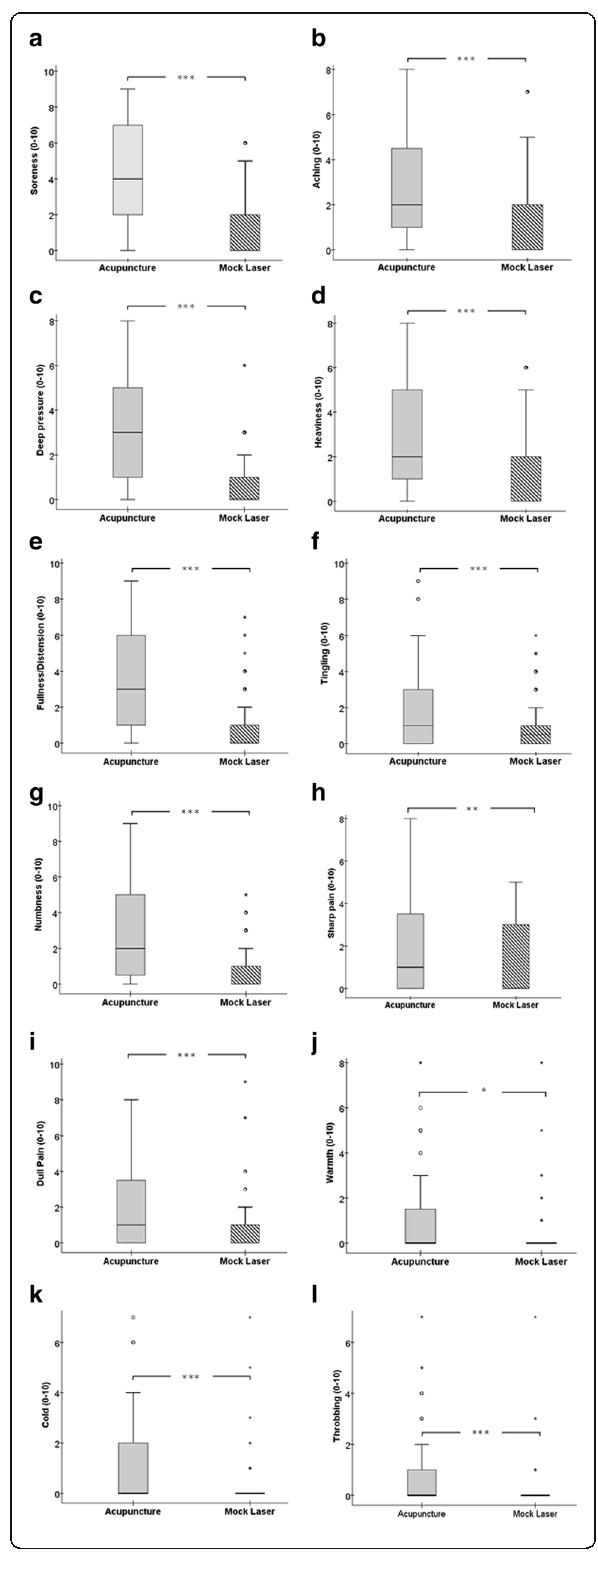
Fig. 6 a - l Comparison of individual De Qi characteristics across the two study groups (acupuncture and mock laser). MASS De Qi score for the acupuncture and mock laser group at the session 1 and session 9, ( n = 47 for the acupuncture group, n = 38 for the mock laser group). The boxes are bound by the interquartile range (IQR) (top of box represents the 75th percentile, while the bottom of the box represents the 25th percentile). The boxes are divided by the median, and the whiskers attached to the box represent the minimum and maximum scores. Extreme values and outliers lied beyond the whiskers and denoted differently with a star and a circle